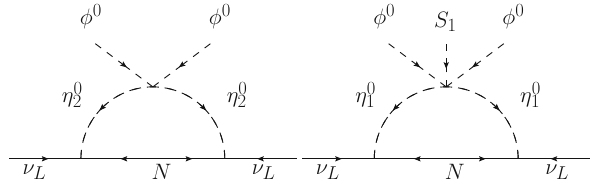
Fig. 1 Radiative neutrino mass at one-loop. Left pattern is for classic scotogenic model, while right pattern is the additional contribution in our